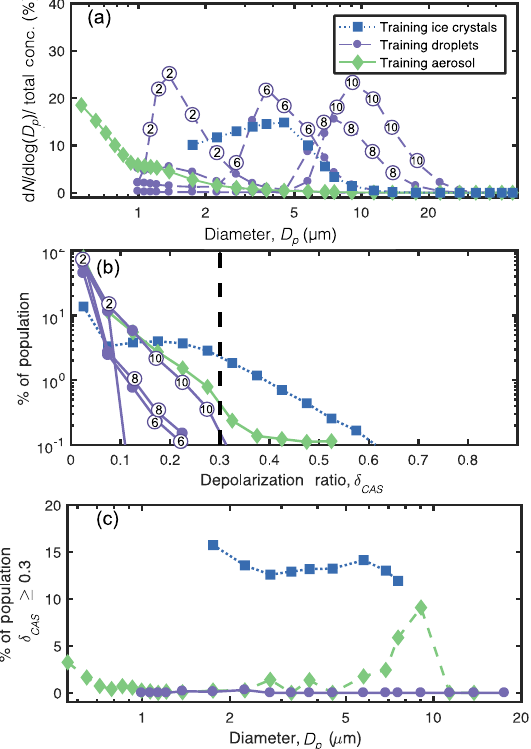
Figure 3. (a) Percent lognormal size distribution, (b) frequency dis- tribution of depolarization ratios, and (c) the percentage of the parti- cles with depolarization ratios above the threshold of 0.3 are shown for training data droplets, aerosols, and ice crystals as detected by the CASPOL. In panel (b) , the depolarization ratio threshold value of 0.3 is indicated by the dashed line. In panel (a, b) , the num- bers displayed in circles provide the diameter in micrometers of the VOAG data represented by that